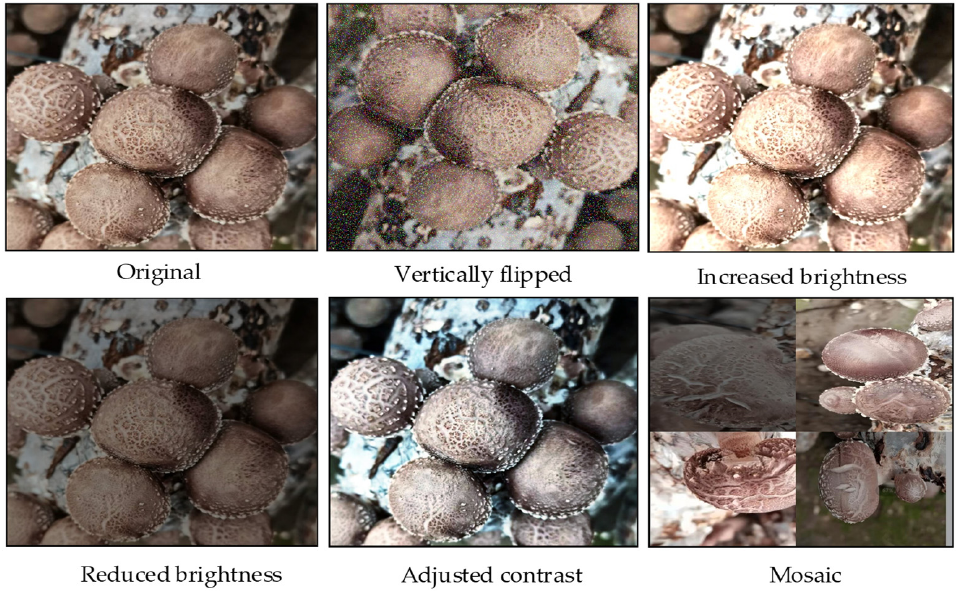
Figure 3. Various types of data enhancement